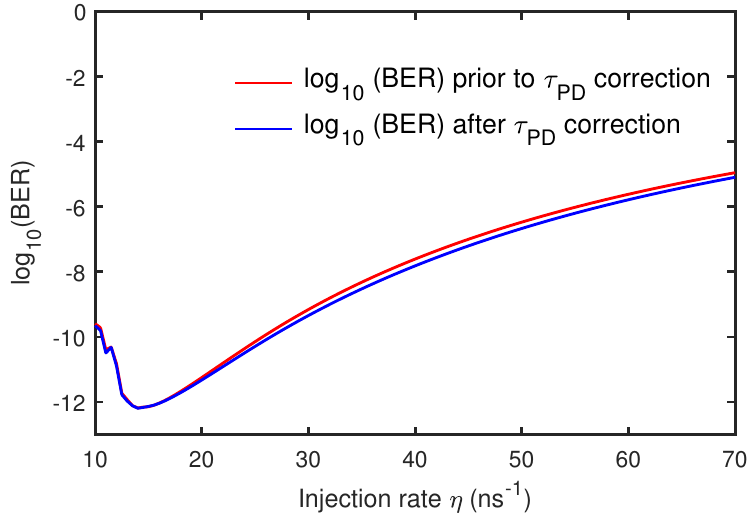
Figure 10. Estimation of BER values of the recovered messages as a function of injection rate for BR = 1.2 Gbit/s, b = 0.2, and ∆ f = 0. Red and blue traces correspond to BER value prior to and after the intra-cavity propagation delay τ PD correction, respectively, in the receiver